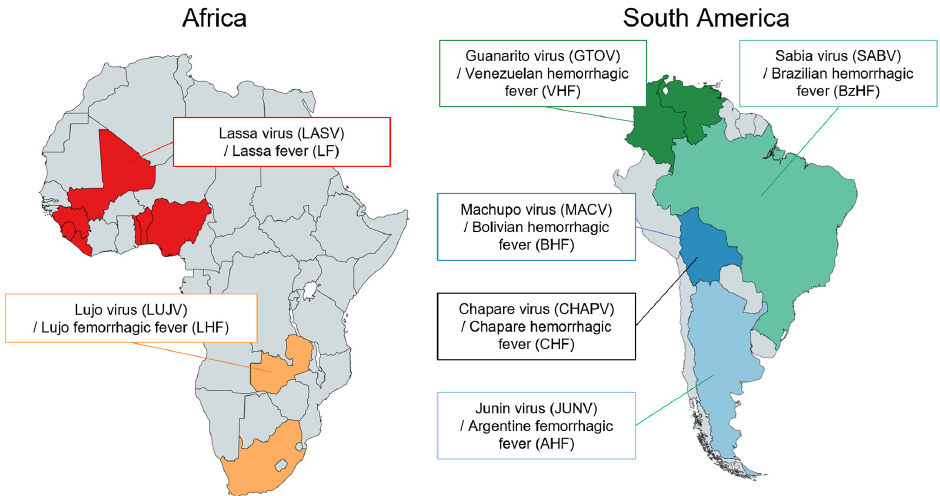
Figure 2. Geographic distribution of human pathogenic arenaviruses. The OW arenaviruses are mainly distributed in the African continent, with the exception of LCMV, which is found worldwide. LASV is endemic in West African countries including Guinea, Liberia, Sierra Leone, and Nigeria, and LUJV is endemic in Zambia and South Africa. The NW arenaviruses are distributed mainly in South America, with JUNV in Argentina, MACV in Bolivia, GTOV in Venezuela and Colombia, CHAPV in Bolivia, and SABV in Brazil. WWAV is found in North America.